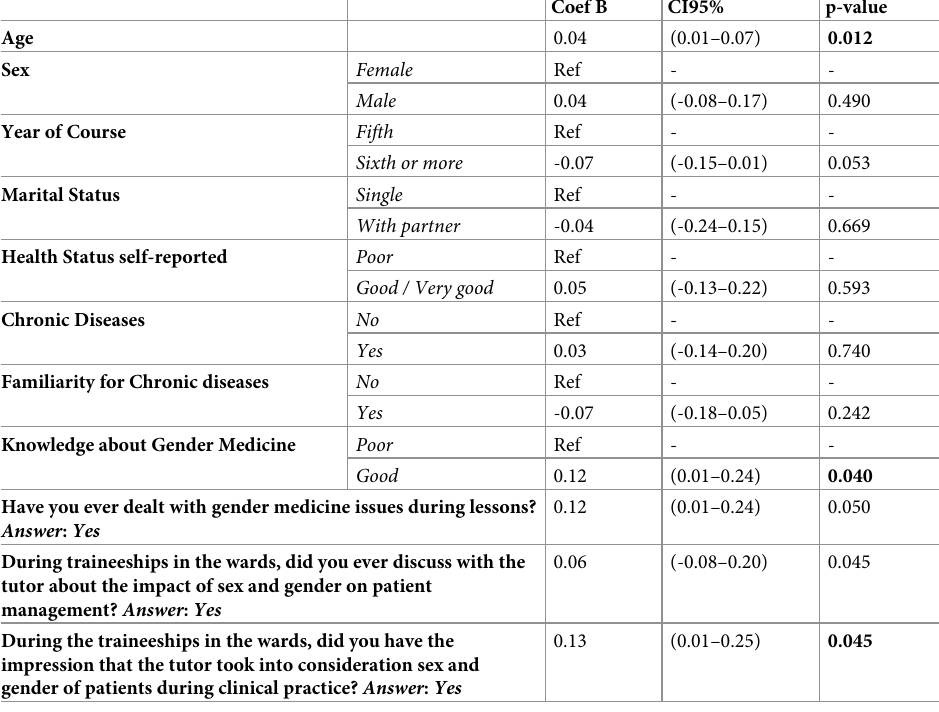
Table 4. Potential predictors of gender role ideology towards patients